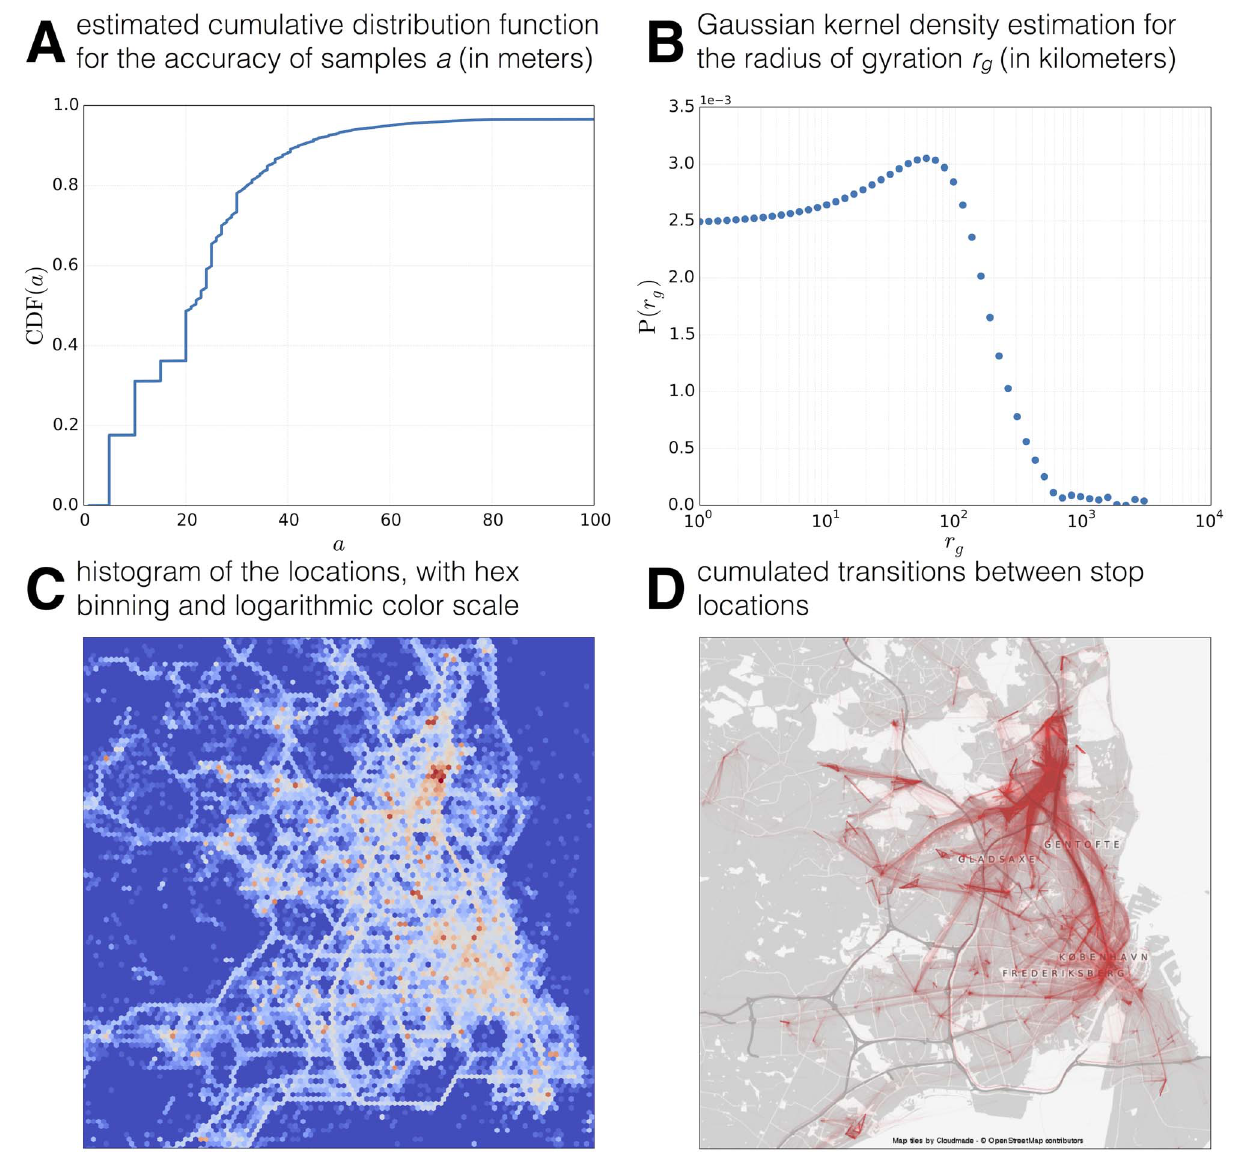
Figure 8. Location and Mobility. We show the accuracy of the collected samples, radius of gyration of the participants, and identify patterns of collective mobility.